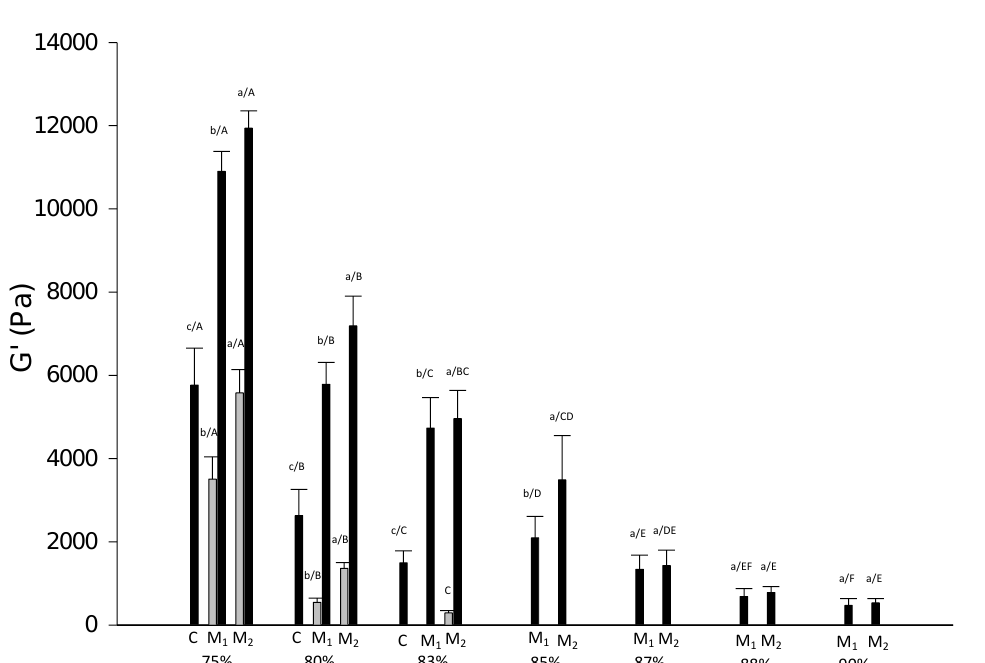
Figure 5. Storage modulus (G’) of systems formed using three different flours, in the CC (grey) and HC (black) and different moisture content (75%, 80%, 83%, 85%, 87%, 88% and 90%). Different letters indicate significative differences among samples ( p < 0.05) where the small letters refer to the differences due to the flours and capital letters refer to the moisture content at the same preparation condition.